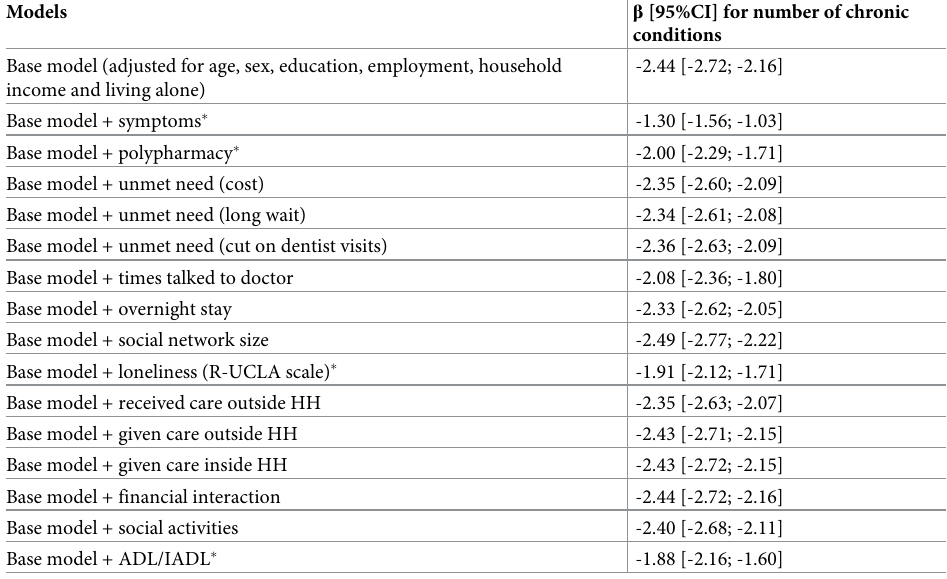
Table 4. Association between number of conditions and quality of life: Estimates from multilevel models adjusted for potential confounders a .